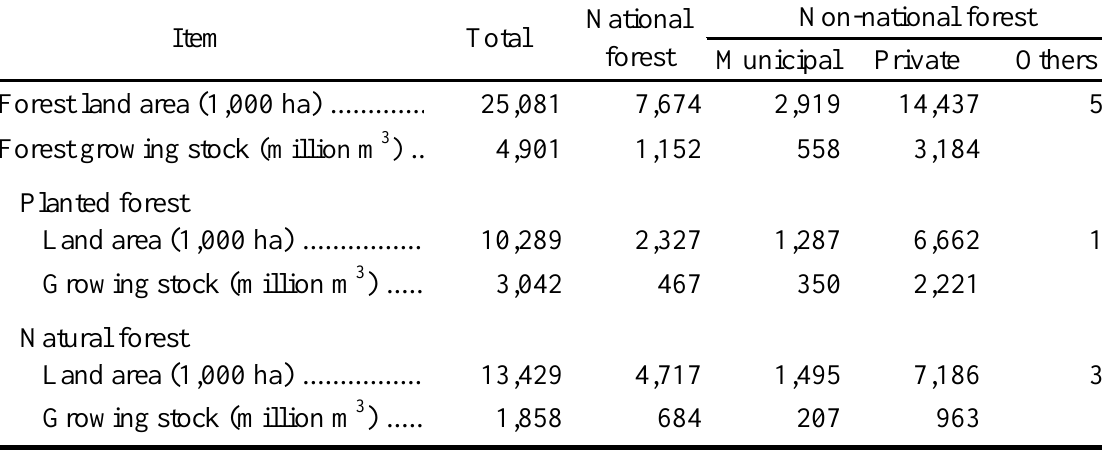
Source: Ministry of Agriculture, Forestry and Fisheries.